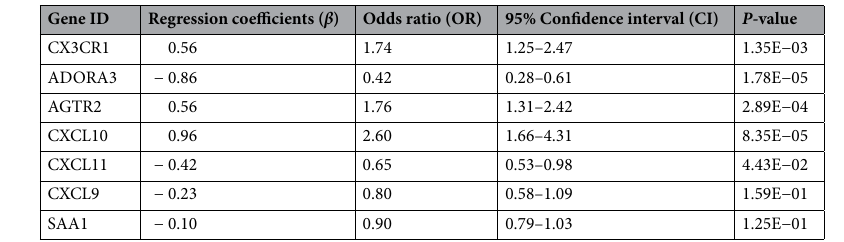
Table 1. Multiple logistic regression of dilated cardiomyopathy.